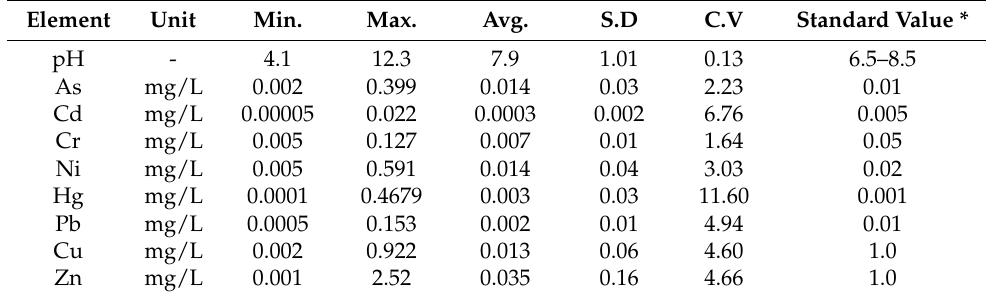
Table 5. Statistical results of heavy metal concentrations.